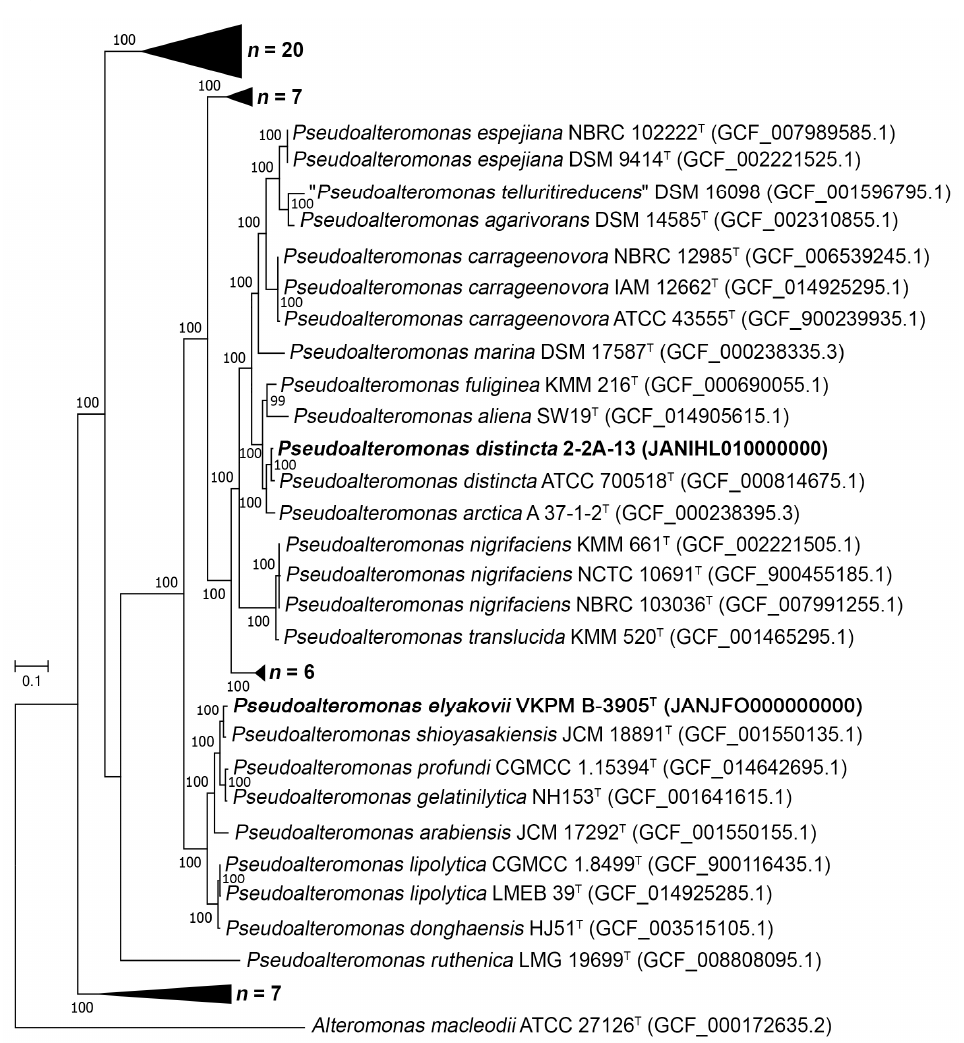
Figure 2. Maximum-likelihood phylogeny of the genus Pseudoalteromonas based on 400 universal markers selected by PhyloPhlAn3.0 and reconstructed by RAxML with non-parametric bootstrapping using 100 replicates, including Bar, with 0.1 substitutions per amino acid position. The corresponding GenBank accession numbers for genomes are given in parentheses. Representatives with novel genomes are in bold.